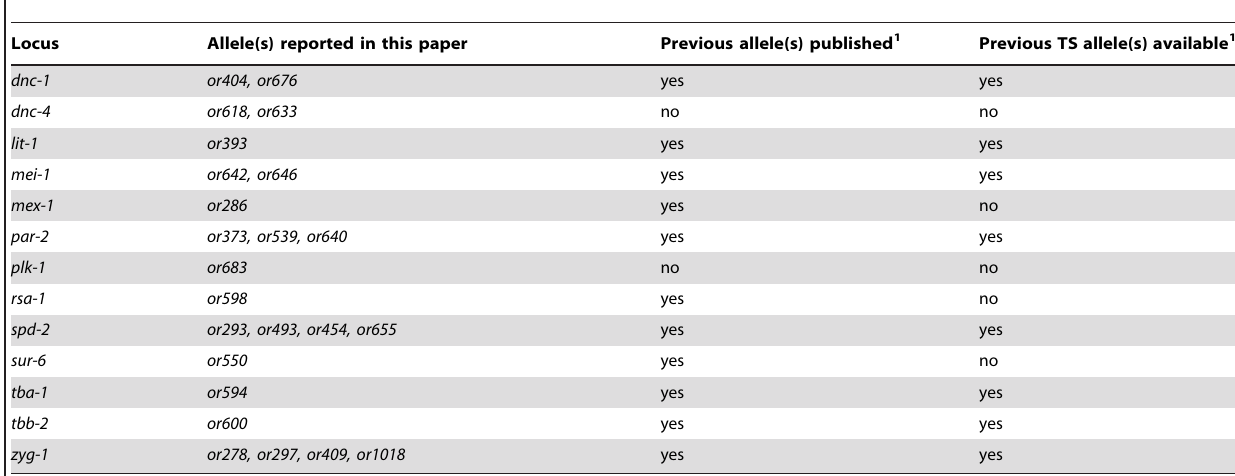
Table 5. Summary of the TS mutant loci and comparison of previously available alleles.